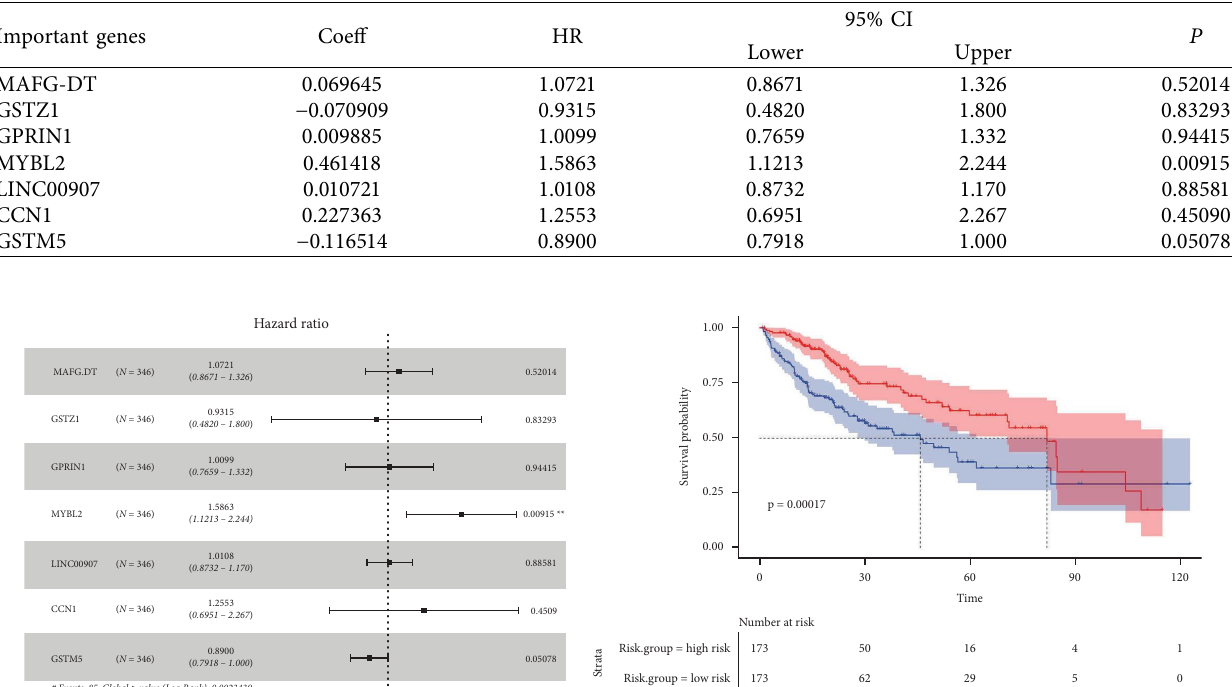
Table 3: Multivariate Cox regression analysis of important DEGs.